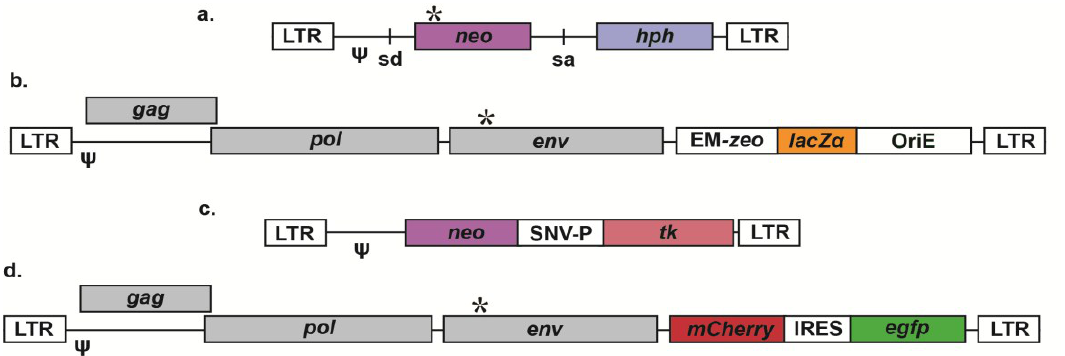
Figure 1. Vectors for the examination of retroviral mutagenesis. Most accessory genes and cis elements are not shown for simplicity; * represents inactivating mutations, while  represents packaging signals. ( a ) SNV vector to detect mutations that restore neo, conferring G-418 resistance [90]; sd = splice donor, sa = splice acceptor. ( b ) HIV-1 vector that detects mutations in lacZα that prevent complementation and expression of functional β-galactosidase in E. coli, ultimately resulting in white bacterial colonies in the presence of X-gal [101]; EM = bacterial promoter, zeo = zeomycin resistance gene, OriE = E. coli origin of replication. ( c ) MLV vector to monitor mutations that eliminate thymidine kinase ( tk ), granting resistance to the thymidine analog bromodeoxyuridine (BrdU) [8]; SNV-P = SNV promoter (U3). ( d ) HIV-1 vector to detect mutations that eliminate expression of mCherry or enhanced green fluorescent protein (EGFP) by flow cytometry [107]; IRES = internal ribosome entry